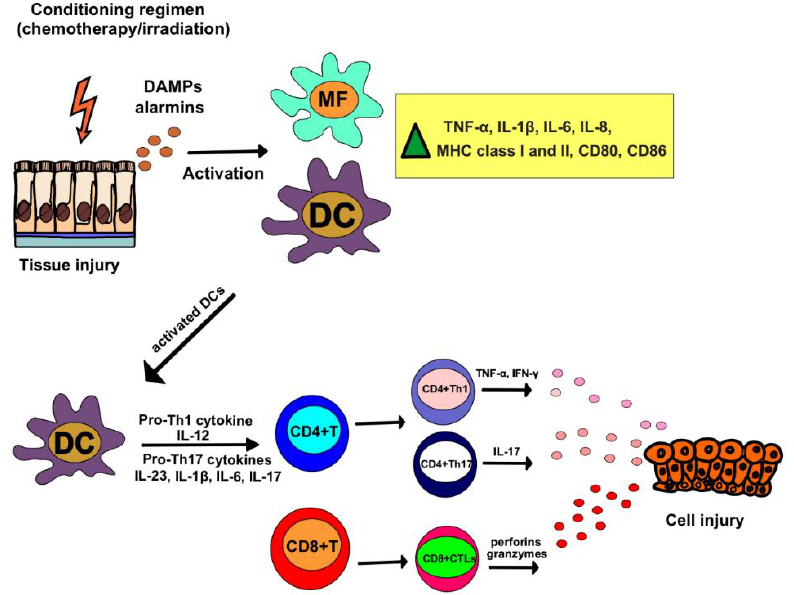
Figure 1. Pathophysiology of oGVHD. Chemotherapy and irradiation, which are used as “precondition treatment” prior to allogeneic HSC transplantation, induce release of damage-associated molecular patterns (DAMPs) and alarmins from injured parenchymal cells, which, in turn, activate tissue resident macrophages and dendritic cells (DCs) to produce large amount of inflammatory cytokines (tumor necrosis factor alpha (TNF- α ), IL-1 beta (IL-1 β ), IL-6, IL-8) and to increase expression of major histocompatibility complex (MHC) and co-stimulatory molecules (CD80, CD86) on their membranes. Activated DCs capture antigens from damaged cells and bring them into the regional lymph nodes to activate donor CD4+T helper and CD8+ cytotoxic T cells. DC-derived IL-12 is responsible for the development of Th1 cells, while DC-sourced IL-1 β , IL-6 and IL-23 induce generation of effector Th17 cells. In addition to CD4+ T helper cells, perforin and granzyme B-producing CD8+cytotoxic T cells (CTLs) are also activated by DCs. Through the production of inflammatory cytokines and cytotoxic molecules, CD4+ and CD8+ T cells induce tissue injury in the eyes of oGVHD